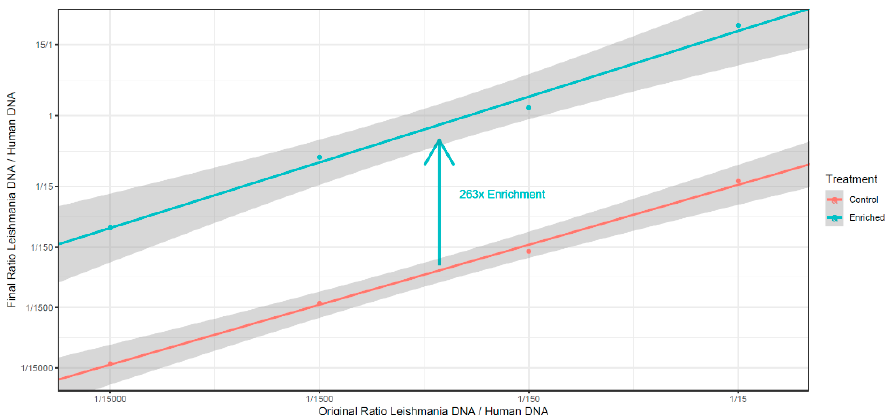
Figure 5. Enrichment (X) of Leishmania DNA in artificial mixtures of Leishmania promastigote DNA and